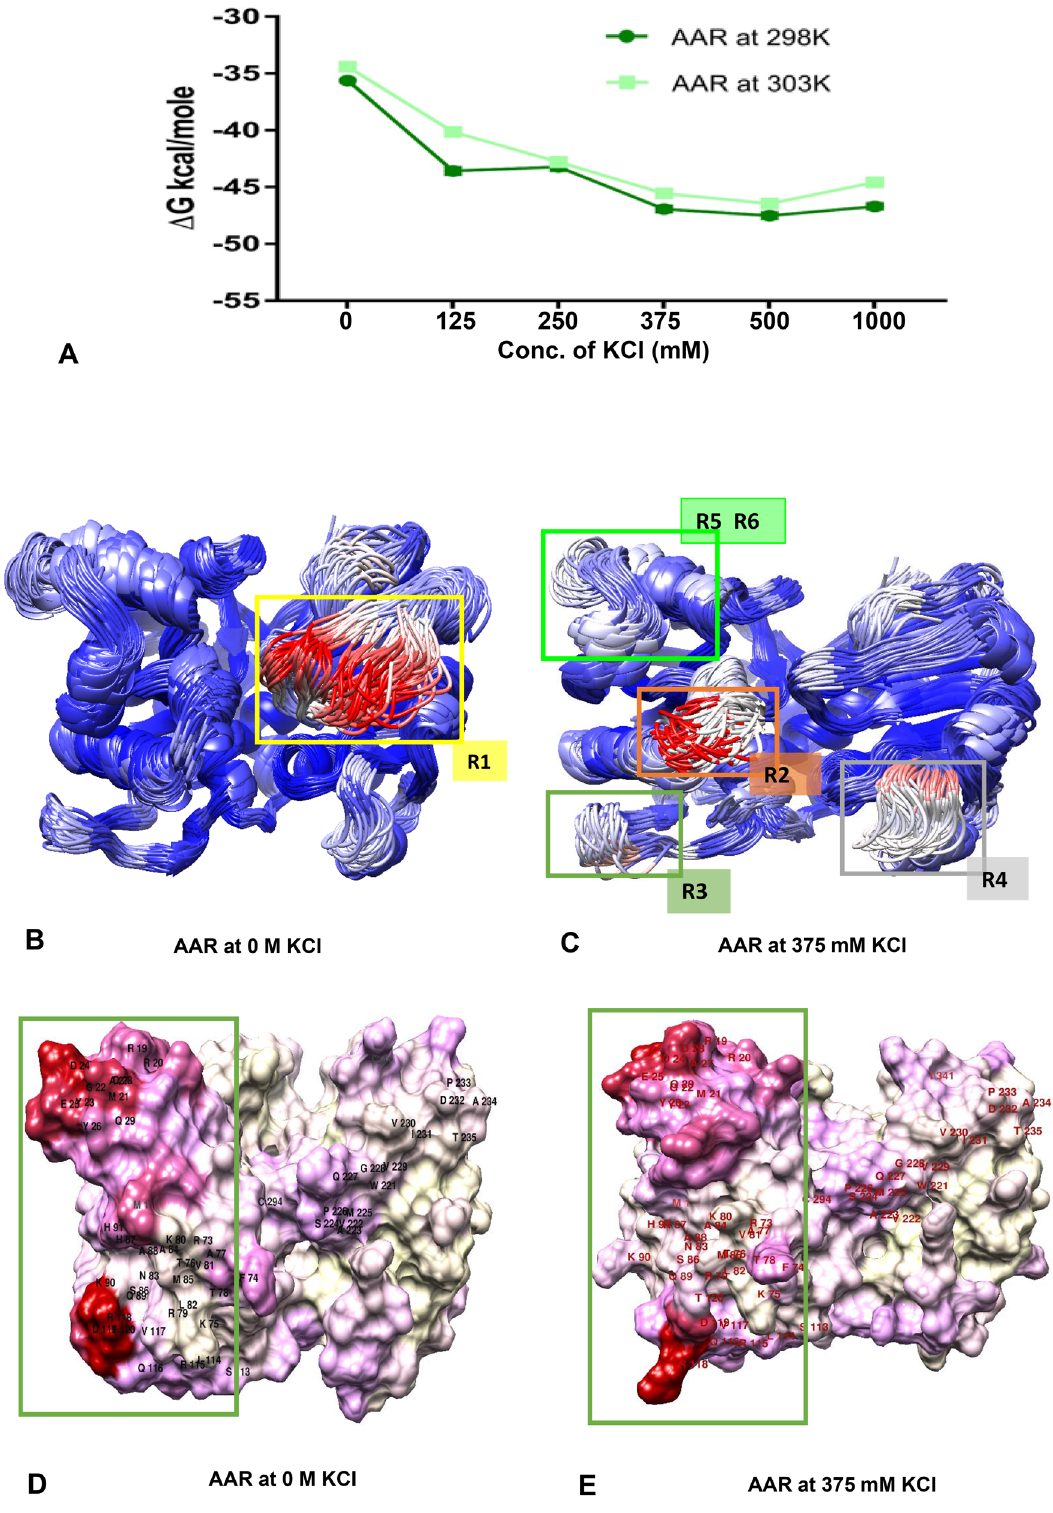
Figure 9. Molecular dynamics simulations of AAR. ( A ) The free energy values of AAR subjected to different concentrations of KCl ranging from 0 to 1000 mM. Energies were derived from Molecular Mechanics Generalized Born Surface Area (MMGBSA) calculations. ( B , C ) The cluster representations of AAR at 0 M and 375 mM KCl over a 200-ns trajectory at 2-ns intervals. The enzymes are colored by RMSF, where red represents the highest fluctuations, and blue represents the lowest fluctuations. Highlighted R1, R2, R3, R4, R5, and R6 correspond to (A223-V230), (L69- R72), (L114-E123), (A188-N190), (A14-D16), and (D28-S35) regions of AAR respectively. ( D , E ). The surface view of the cluster representative of AAR subjected to 0 M and 375 mM KCl solvent environment, here red and cream color represent maximum and minimum difference respectively in their structures when aligned and compared with each other. Chimera tool 32 was used for visualizing these